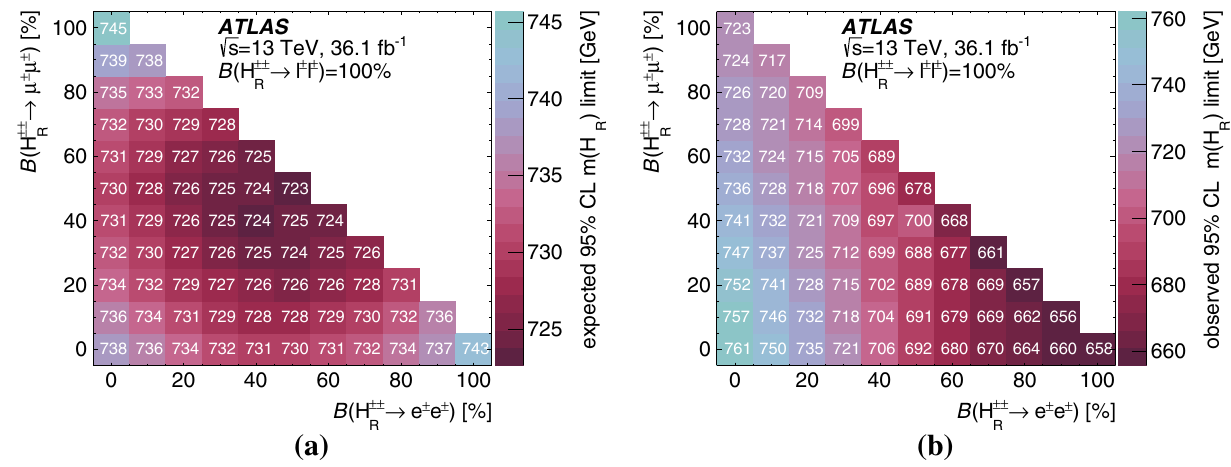
Fig. 12 The a expected and b observed lower limits on the H ±±